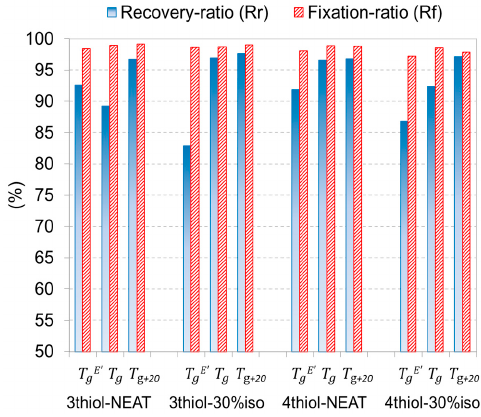
Figure 10. Recovery-ratio and fixation-ratio as a function of the programming temperature for all the formulations of study. formulations of